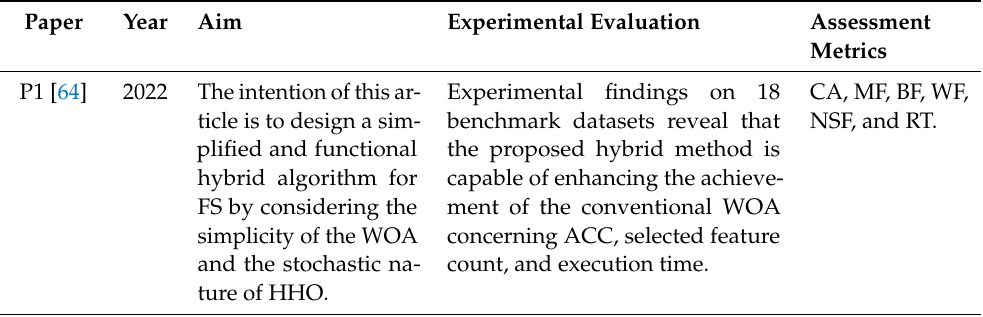
Table 2. Introduction to the collected